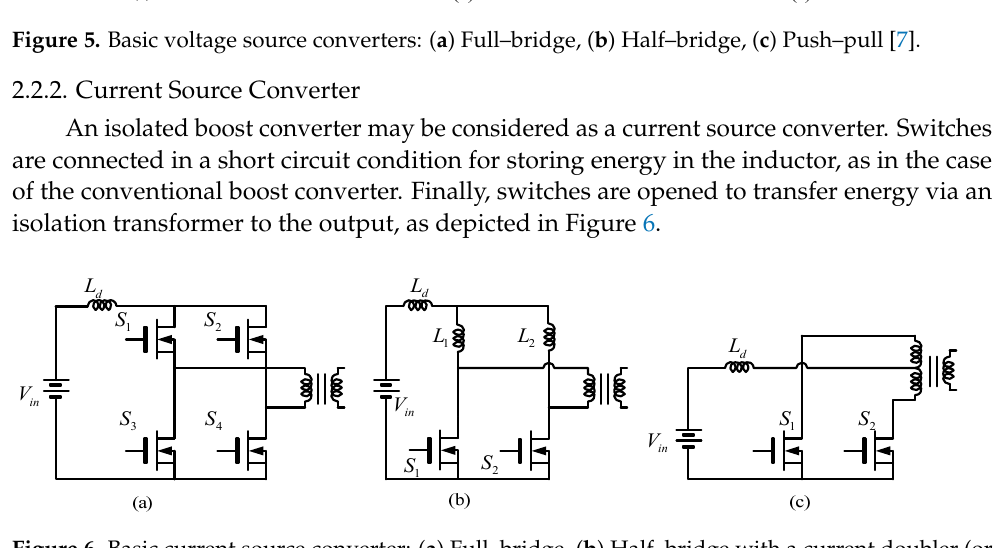
Figure 6 . Basic current source converter: ( a ) Full–bridge, ( b ) Half–bridge with a current doubler (or L–type), ( c ) Push–pull [7].